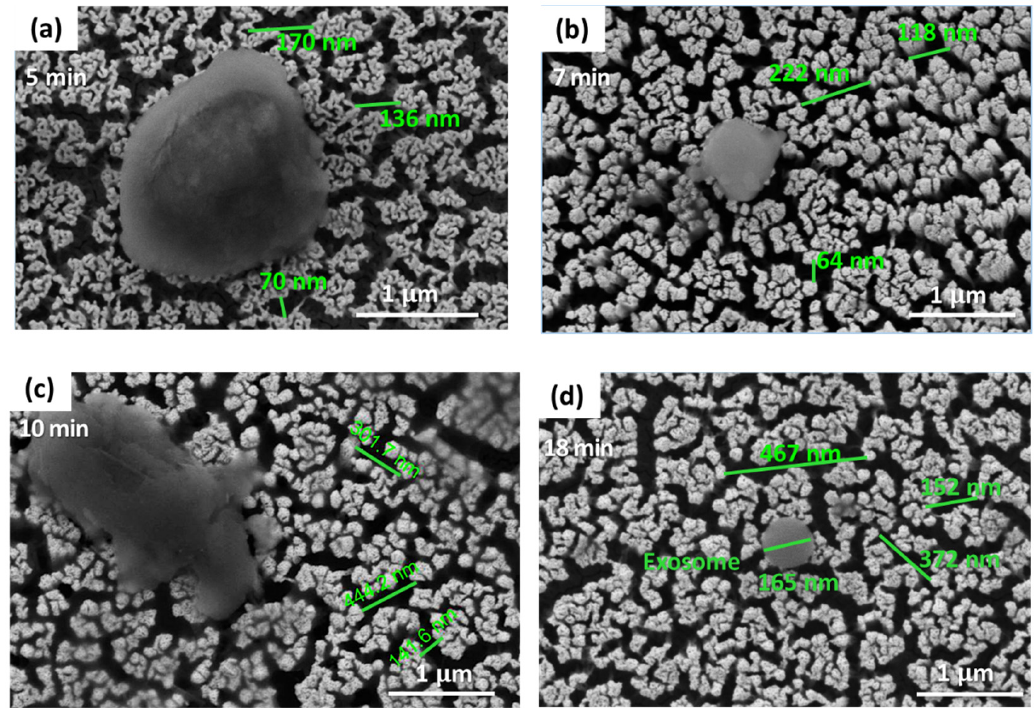
Figure 11. SEM micrograph showing porous gold substrates at different pore sizes: ( a ) Porous gold substrate treated for 5 min, ( b ) Porous gold substrate treated for 7 min, ( c ) Porous gold substrate treated for 10 min, ( d ) Porous gold substrate treated for 18 min.